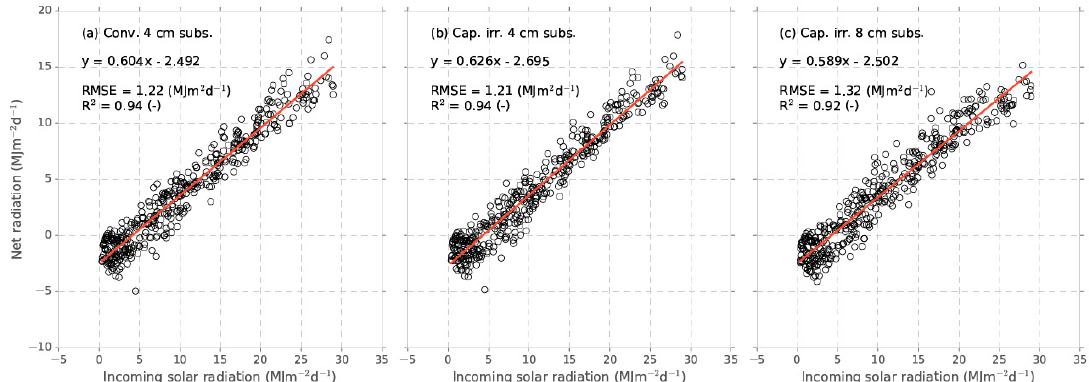
Figure A2. Linear regression between on-site measured incoming solar radiation R s and net radiation R n .